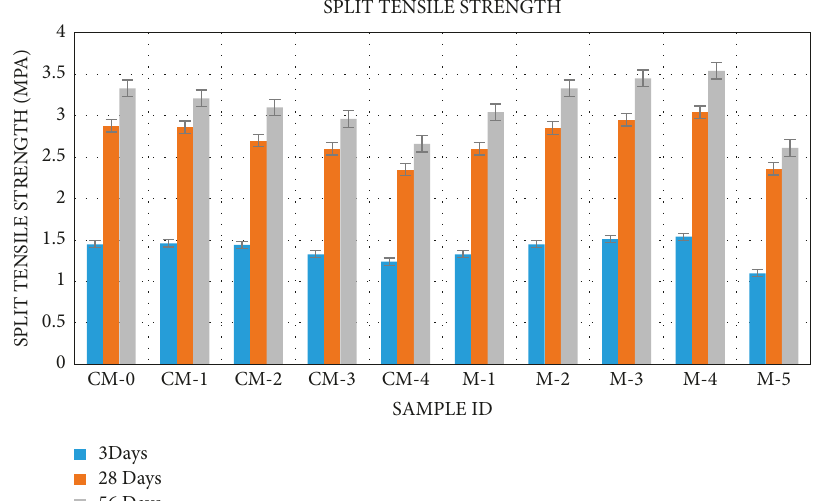
Figure 6: 3D surface diagram for flexural strength.